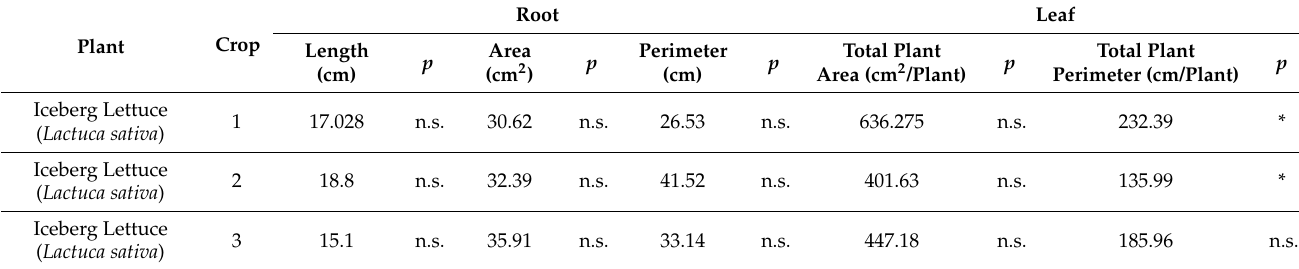
Table 2. Leaf and root growth parameters.